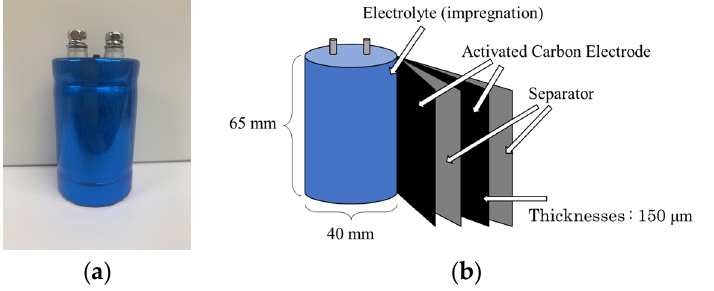
Figure 1. ( a ) Investigated electric double-layer capacitors (EDLCs) and ( b ) their configuration.